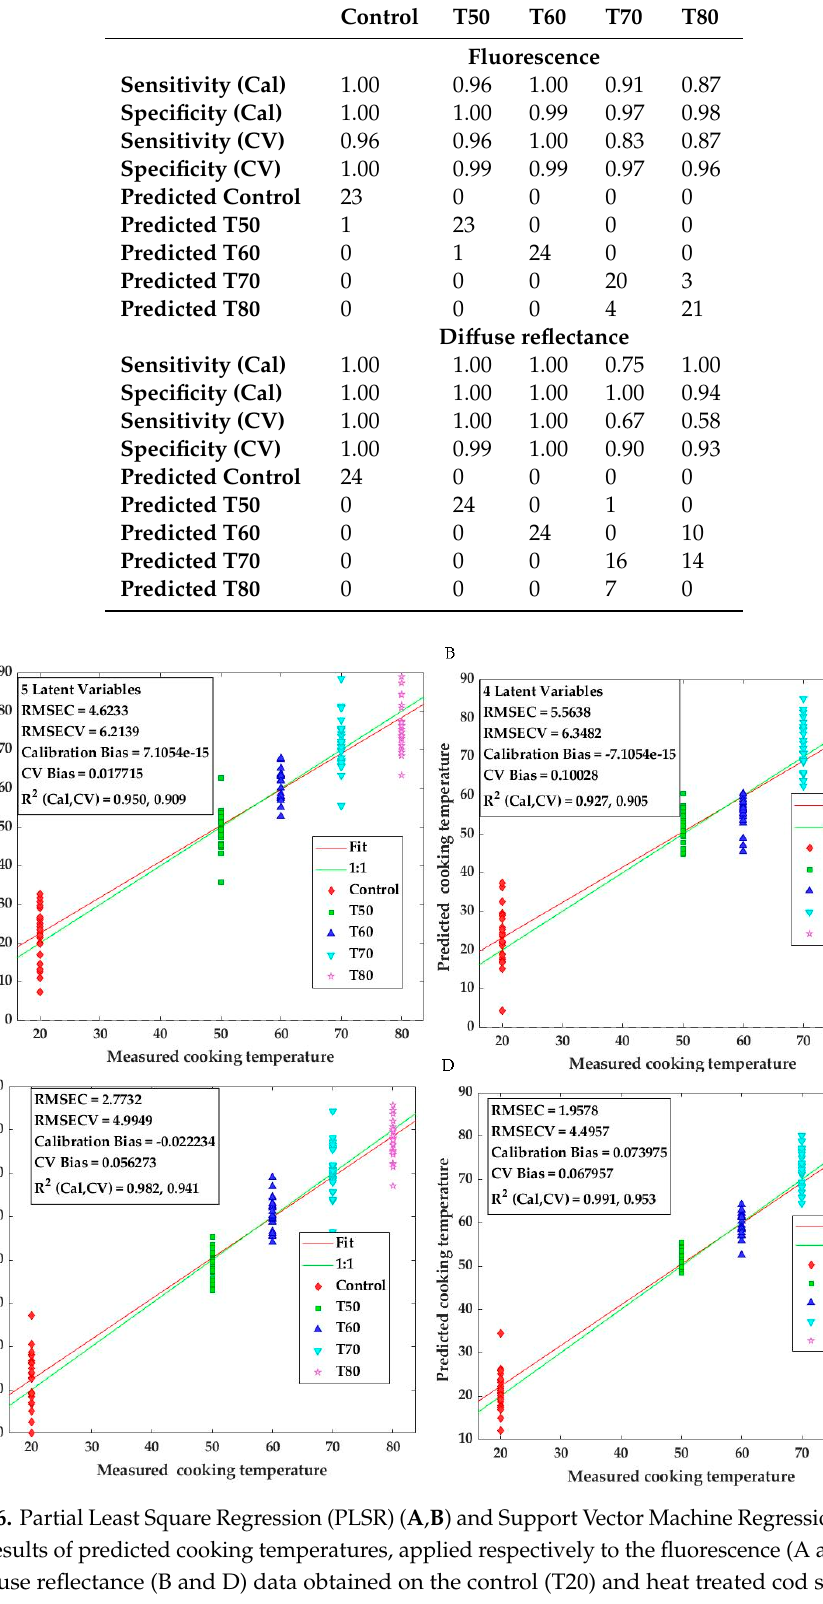
Table 3. Results of support vector machines classification (SVMC) models applied to the fluorescence and di ff use reflectance data sets.